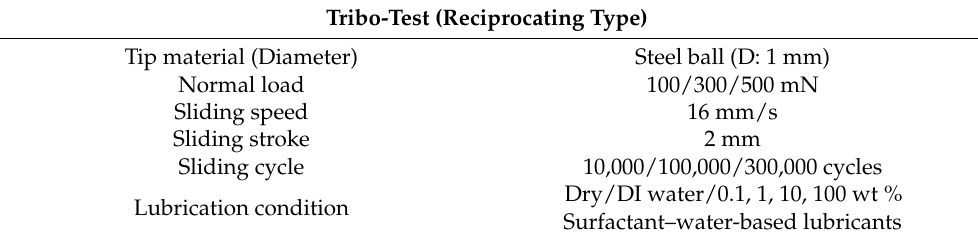
Table 2. Tribo-test conditions.